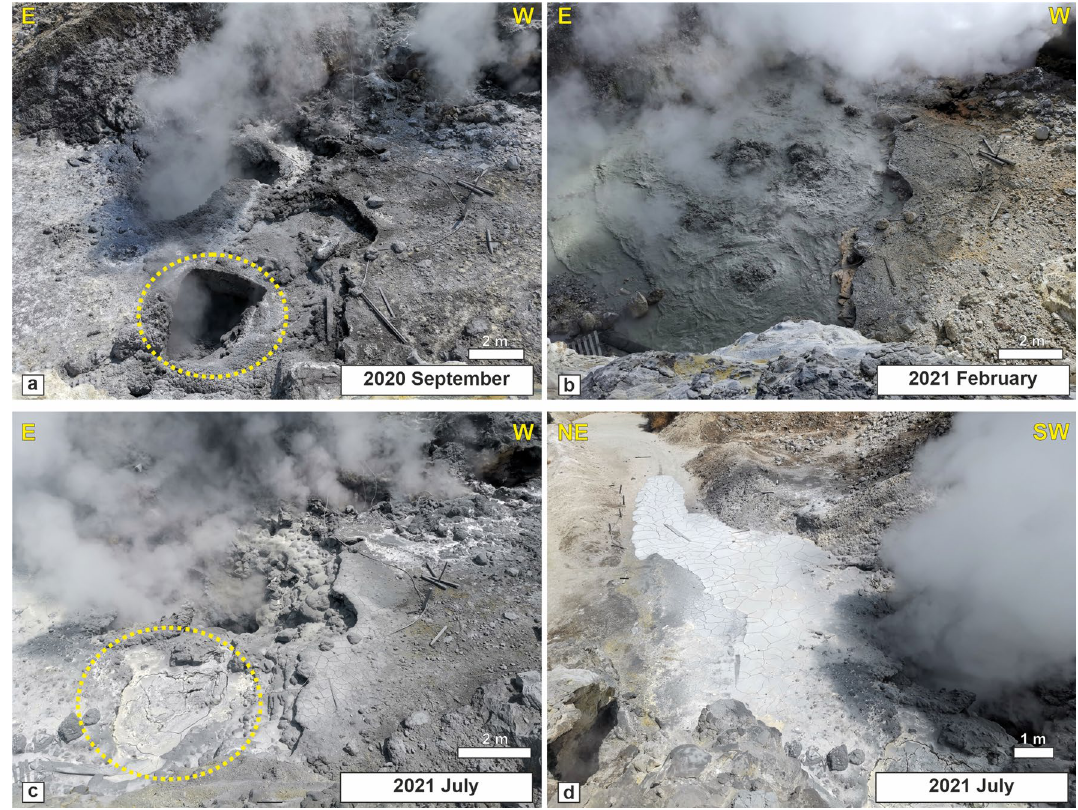
Figure 9. Photographic representation of the mud pool area in Sept 2020 ( a ), Feb 2021 ( b ), and July 2021 ( c , d ). Arrangement of pictures and photos by Roberto